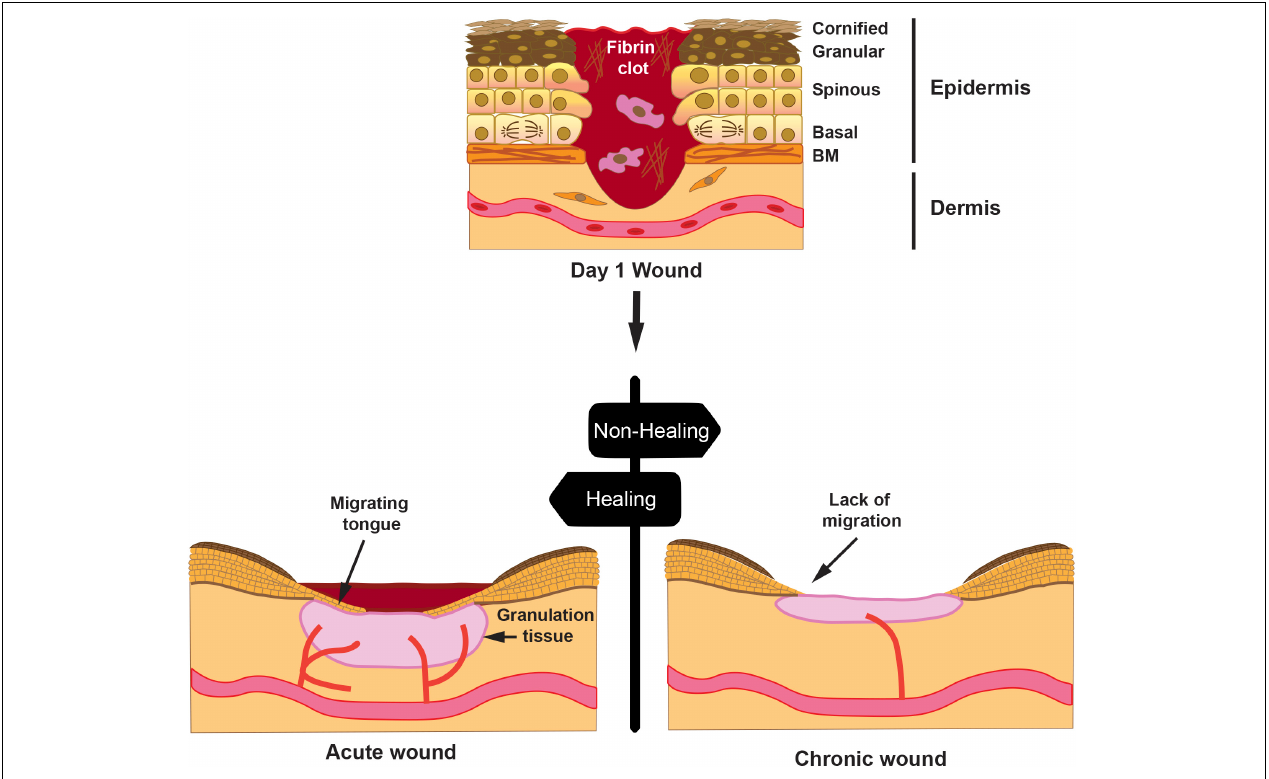
FIGURE 1 | Progression of a wound. A full-thickness wound is depicted at day 1 post-injury; the skin epithelium with its cell layers indicates that the keratinocytes from the spinous layer are activated for migration, whereas keratinocytes from the basal layer proliferate to sustain cell numbers during migration. Hemostasis occurring on day 0 creates a fibrin clot with immune cells, such as macrophages. Later, an acute wound will proceed with healing with reduction of the fibrin clot, formation of granulation tissue, and re-epithelialization by creating a migrating tongue. However, in a chronic wound, granulation tissue is diminished, re-epithelialization is halted, and wound remains open after an extended time. Drawn cells in the dermis represent